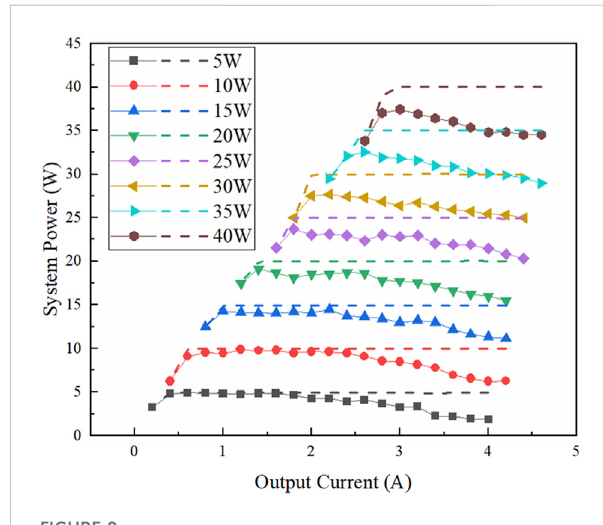
Figure 9. The system ’ s output powers are represented by marked lines and the controlled powers of the stacks are represented by dashed lines. It is observed that the power regulation system board works as the model predicts: the system regulates the output power of the fuel cell stack to a designated value in each active zone and the fi nal output suffers some conversion losses. The average ef fi ciency at 35 W goes up to 85%. The system is competent in regulating the output power of the fuel cells in portable applications, with relatively high ef fi